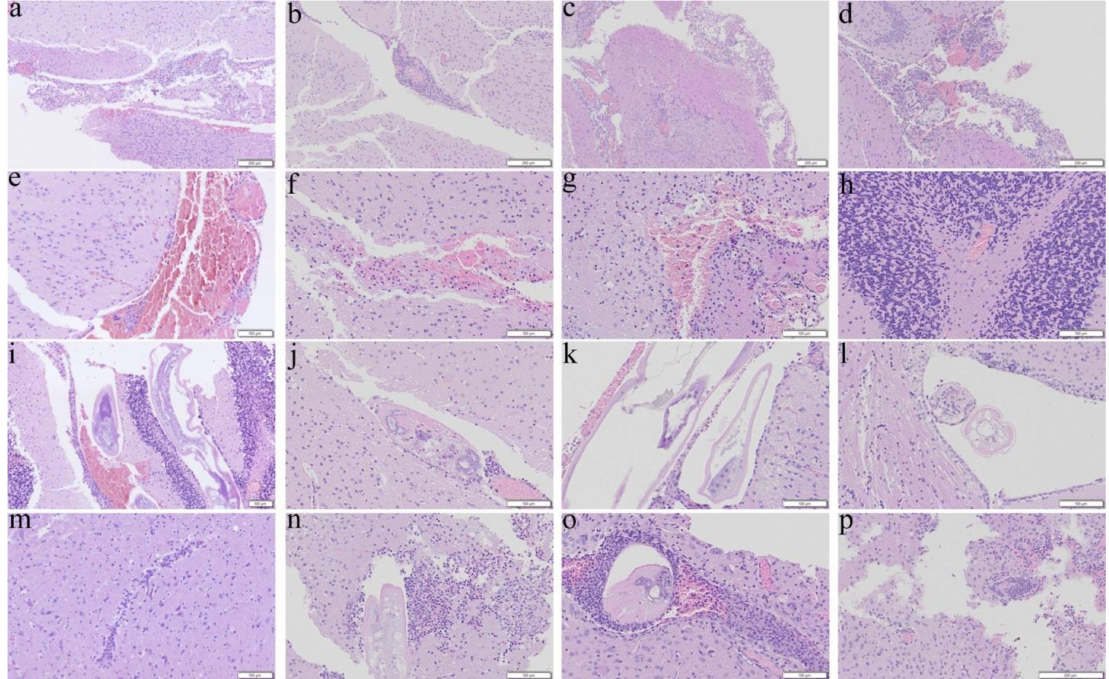
Figure 4. Representative photomicrographs showing meningitis, presence of worms, hemorrhage, and encephalitis in the cerebral parenchyma of the BALB/c mice infected with Angiostrongylus cantonensis treated from day 14 for 14 days. ( a , e , i , m ) Untreated mice. ( b , f , j , n ) Mice treated with albendazole alone. ( c , g , k , o ) Mice treated with dexamethasone alone. ( d , h , l , p ) Co-therapy of albendazole and